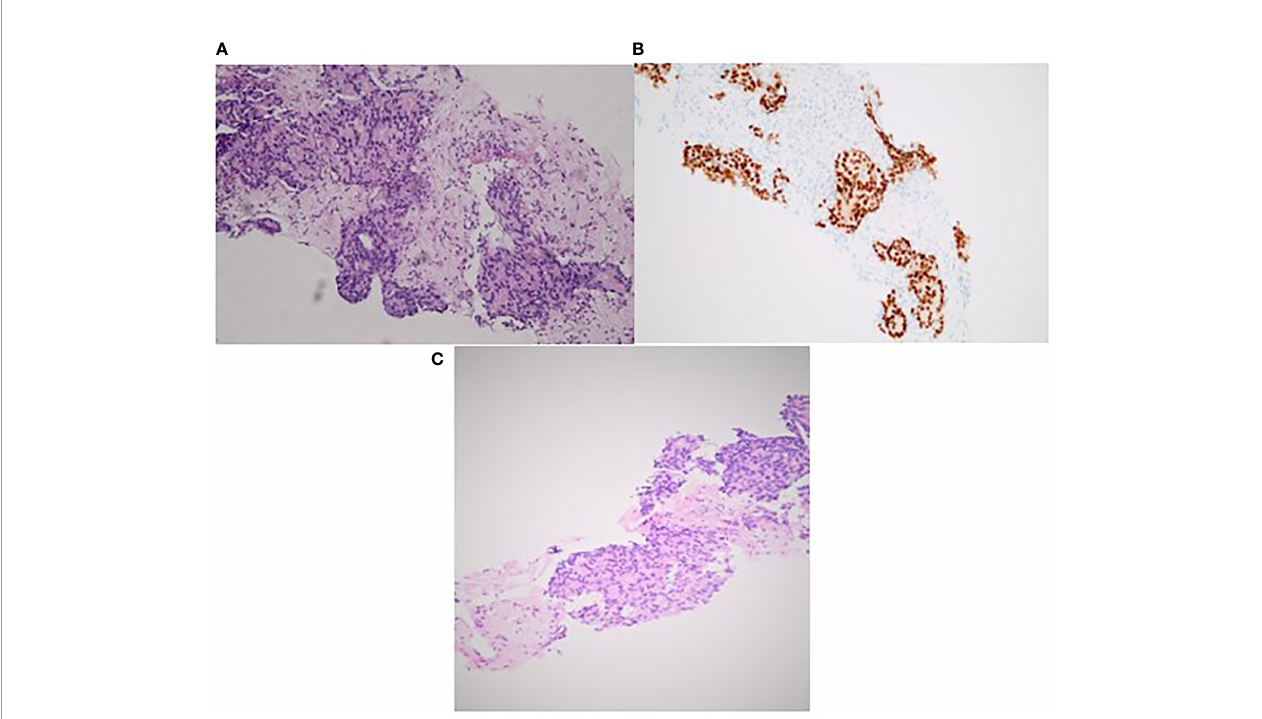
FIGURE 3 | Histopathology fi ndings of liver biopsy lesions con fi rming prostatic origin with cribriform pattern (A) . Positive staining for PSA (B) . Hematoxylin and eosin stain (×20) (C) .